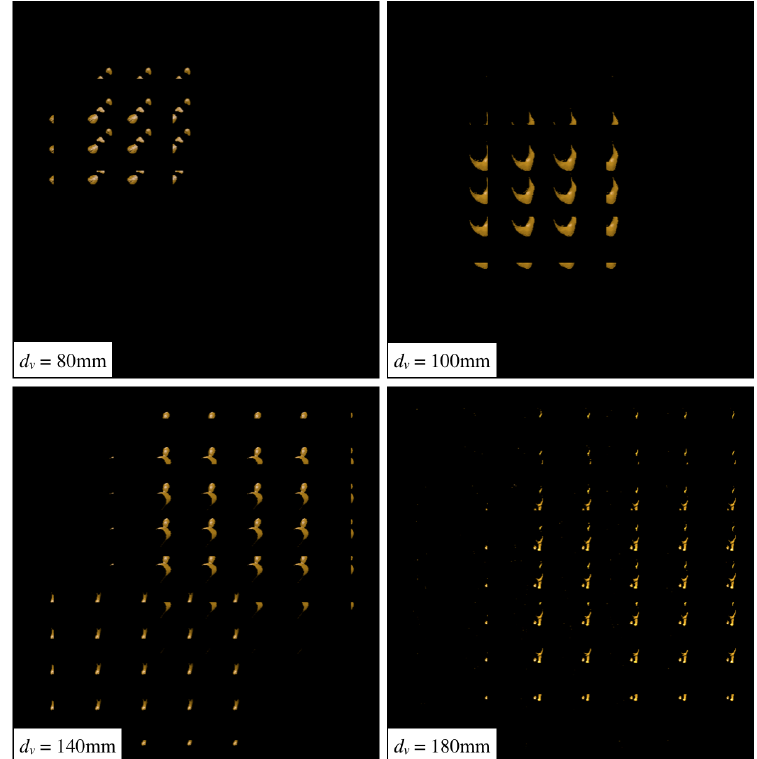
Figure 5. Displayed patterns of the dog for different exemplary depth planes.